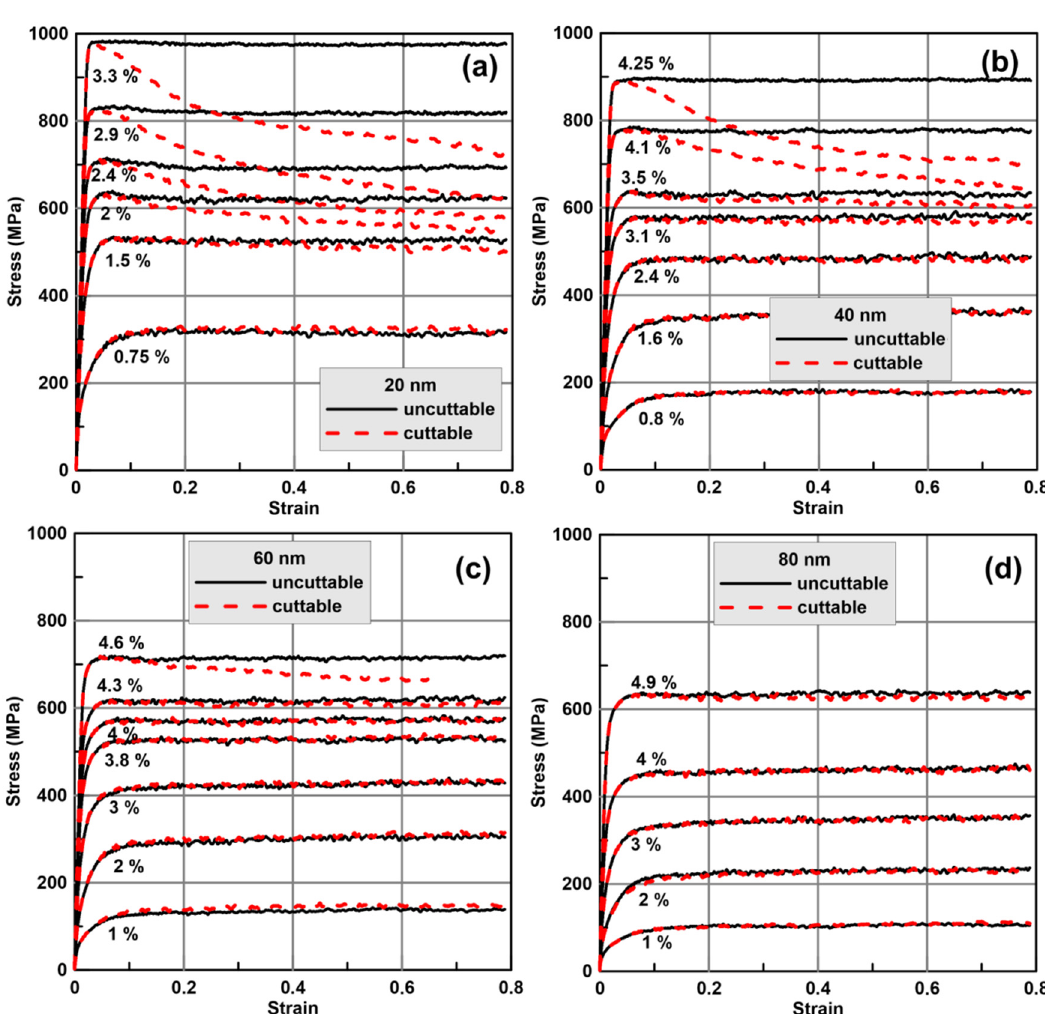
Figure 11. Results of 2D dislocation dynamics calculation for aluminum with θ ’ precipitates for different typical sizes (( a )—20 nm, ( b )—40 nm, ( c )—60 nm, ( d )—80 nm) and volume fractions: stress-strain curves calculated in approximation of constant size of precipitates (“uncuttable”) and accounting for their size evolution (“cuttable”).